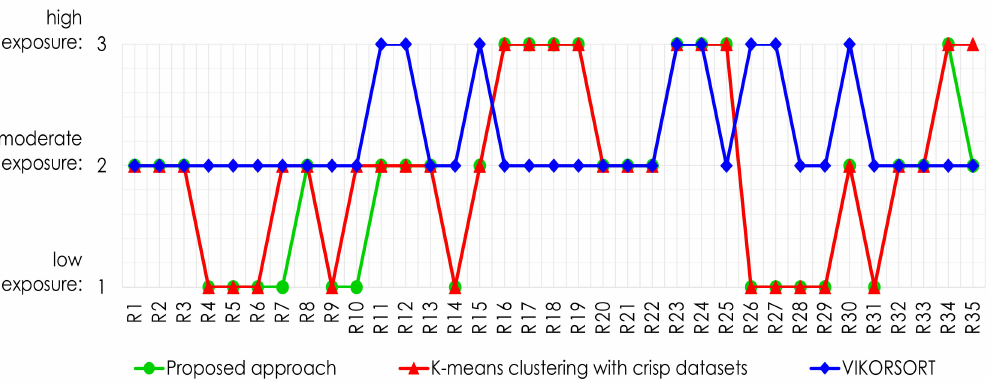
Figure 3. Assignments of tourist sites to clusters with VIKORSORT, k -means clustering with crisp datasets, and the proposed